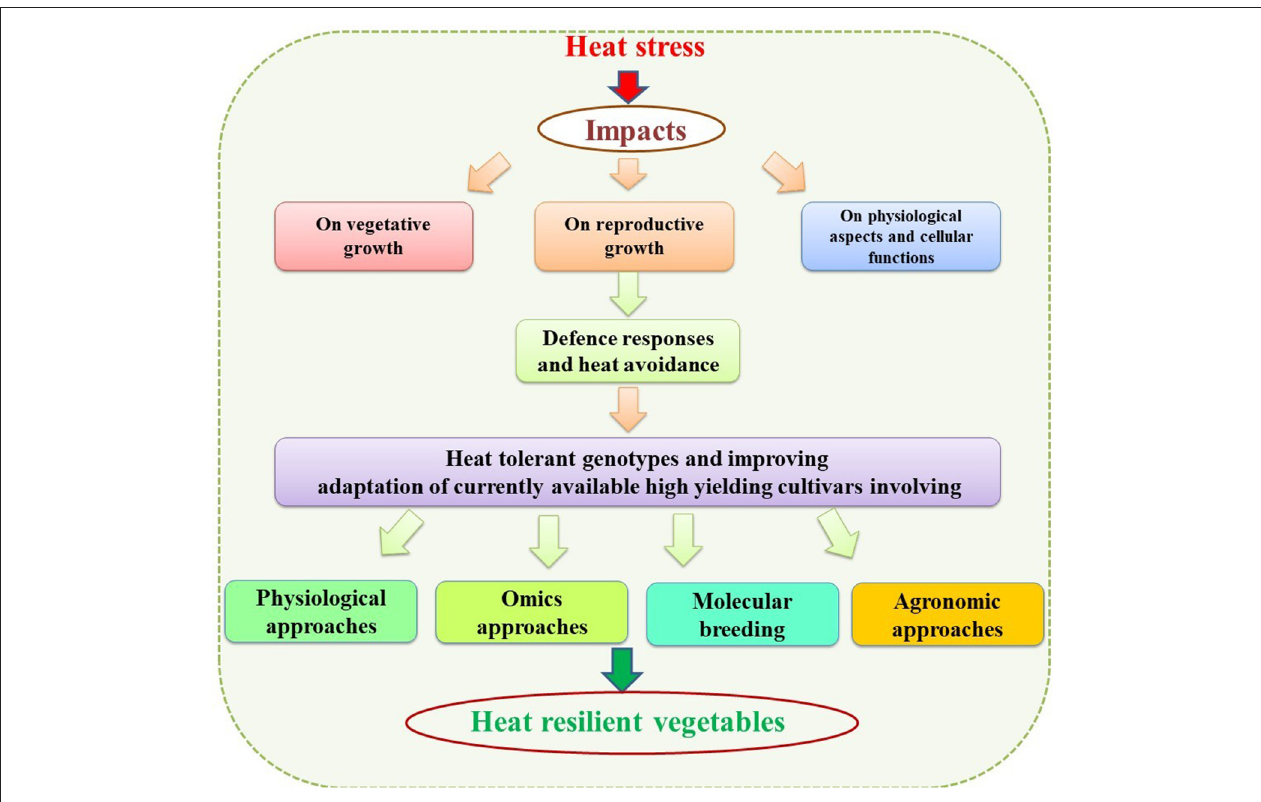
FIGURE 5 | Heat stress has various negative impacts on the plant like reducing vegetative and reproductive growth, interfering with the physiological and cellular functions. To combat such impacts, plant activates multiple responses and heat avoidance mechanisms which can be used to identify heat resilient vegetable crops. Different approaches categorized in this article for this purpose are physiological based, omics based, molecular breeding based and agronomic based. Such possible options will pave the way for improving adaptation and mitigation of heat stress in vegetable